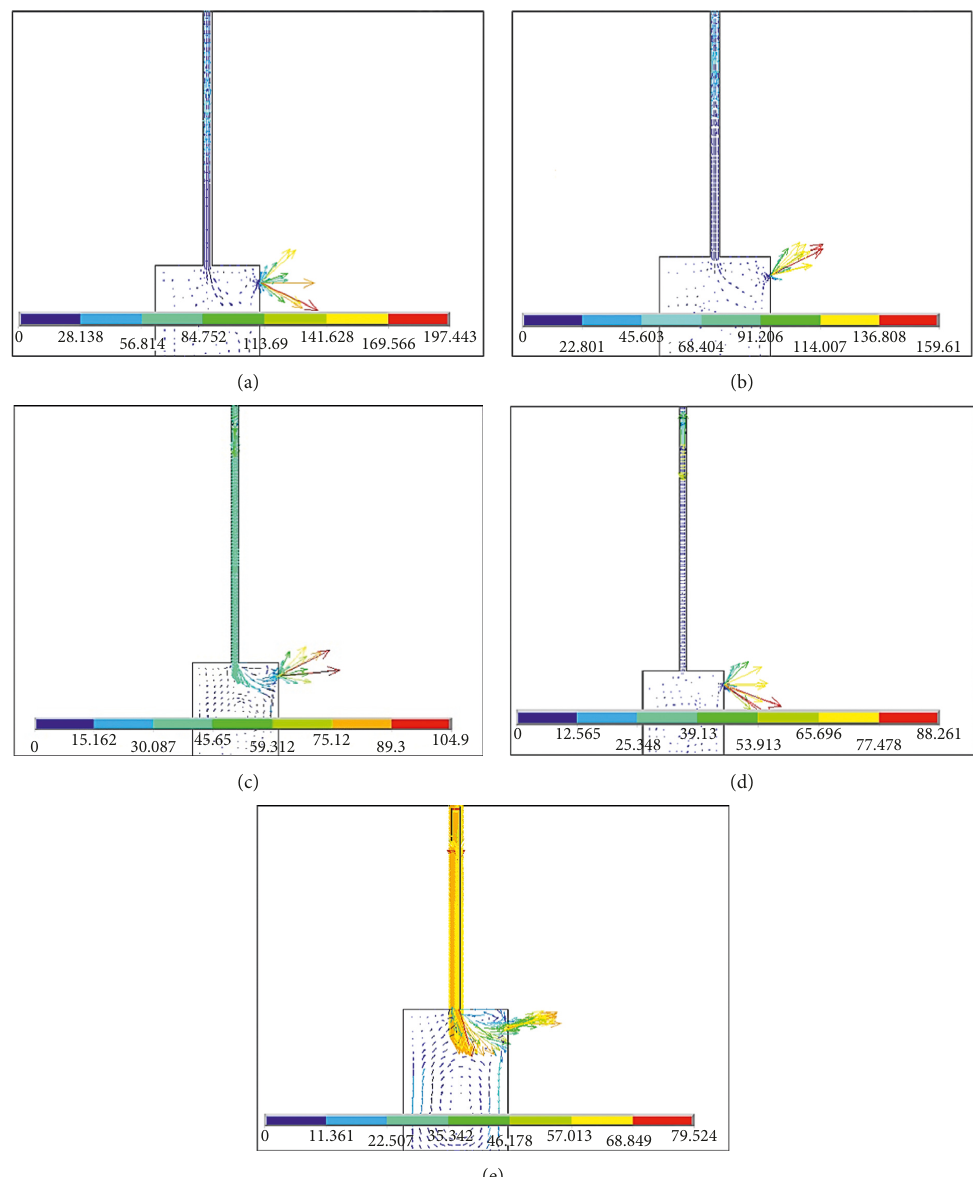
Figure 20: Vector diagram of flow field rate with different vent diameters. (a) Vent diameter of 10mm. (b) Vent diameter of 30mm. (c) Vent diameter of 50mm. (d) Vent diameter of 70mm. (e) Vent diameter of